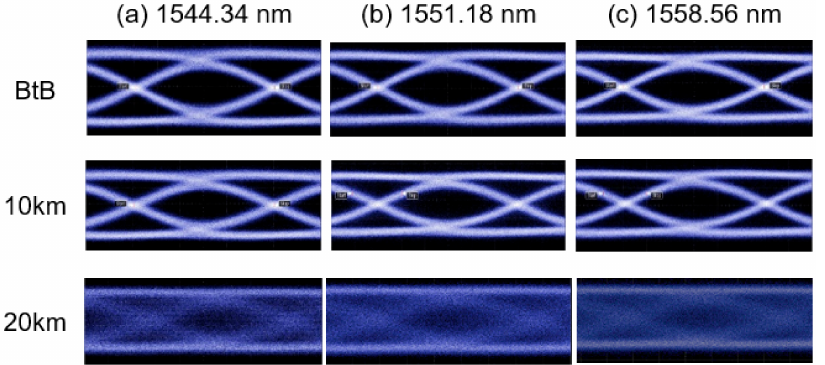
Figure 6. A 25 Gb/s eye diagram of a tunable DBR laser for BtB, 10 km, and 20 km transmission when the tuned wavelength is ( a ) 1544.34 nm, ( b ) 1551.18 nm, and ( c ) 1558.56